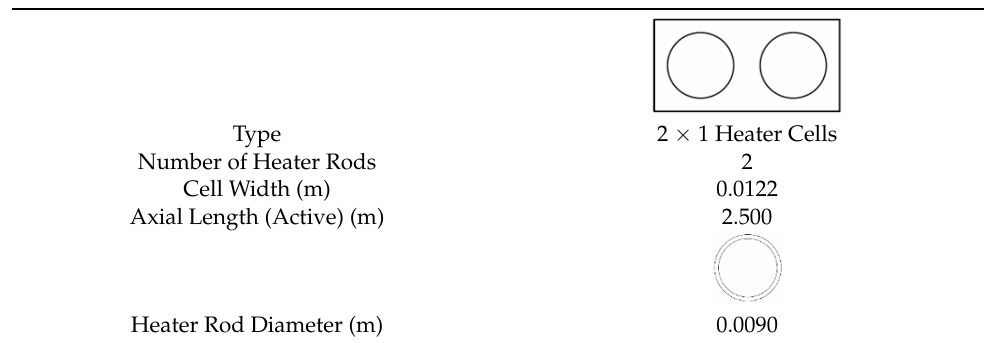
Table 6. 2 × 1 geometry from the FLOCAL developer benchmark.